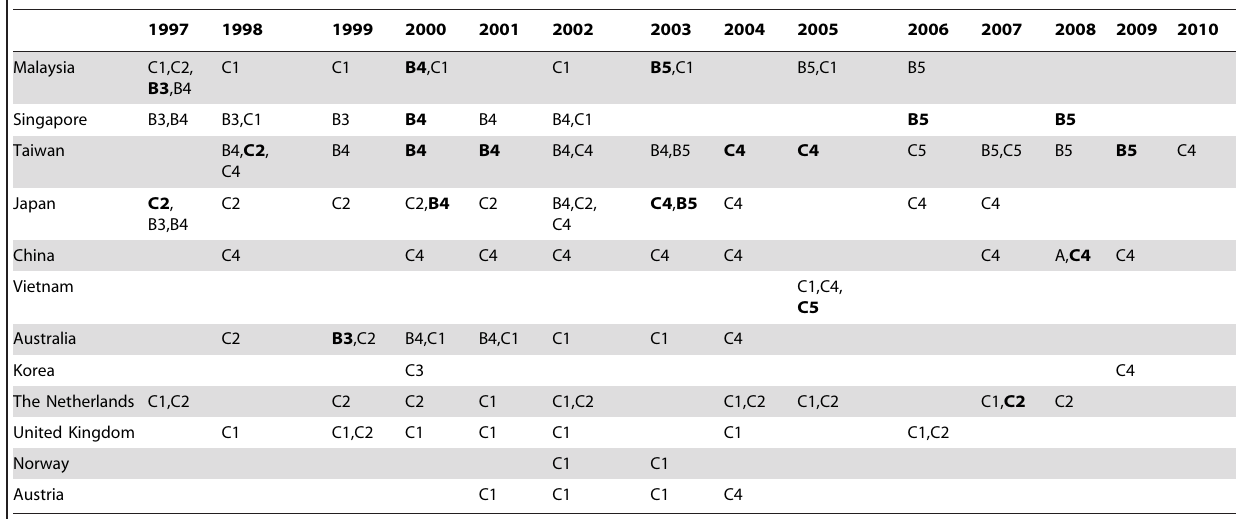
Table 6. Distribution of EV71 genotypes throughout the world from 1997 to 2010.